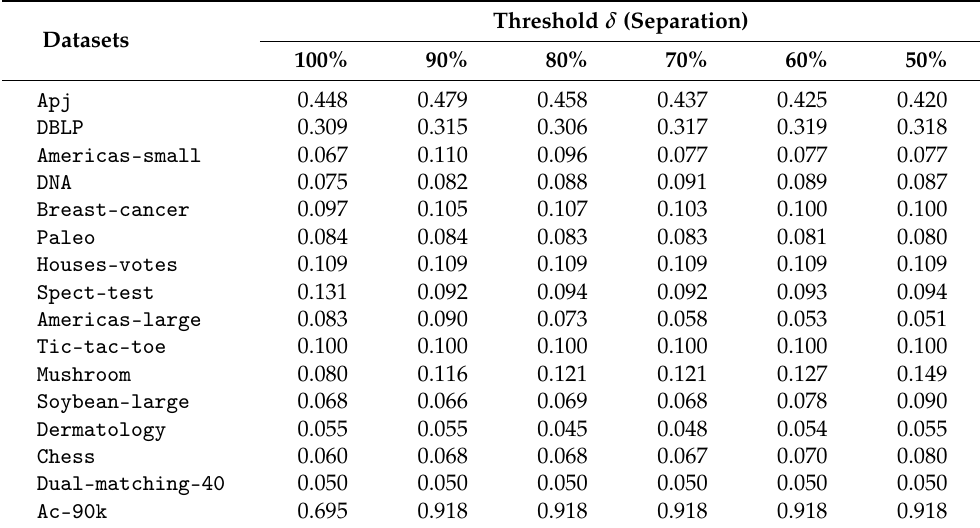
Table 11. The separation of the C ONCISE algorithm with different